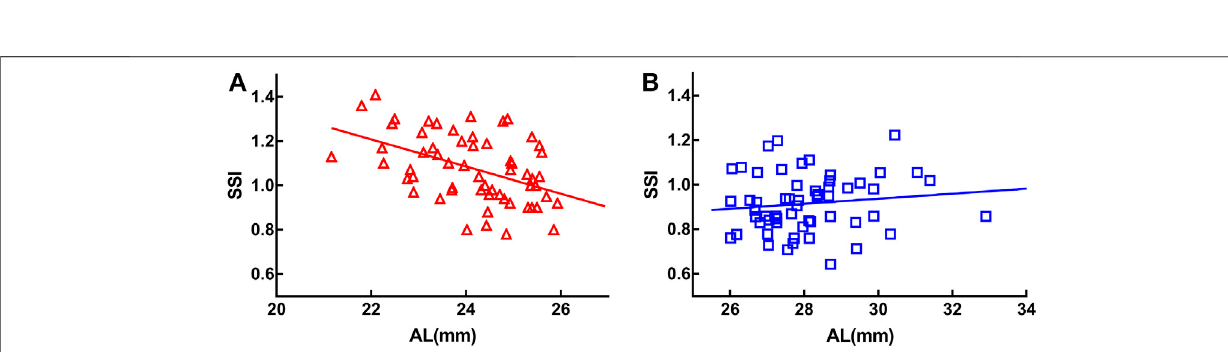
Frontiers in Bioengineering and Biotechnology |